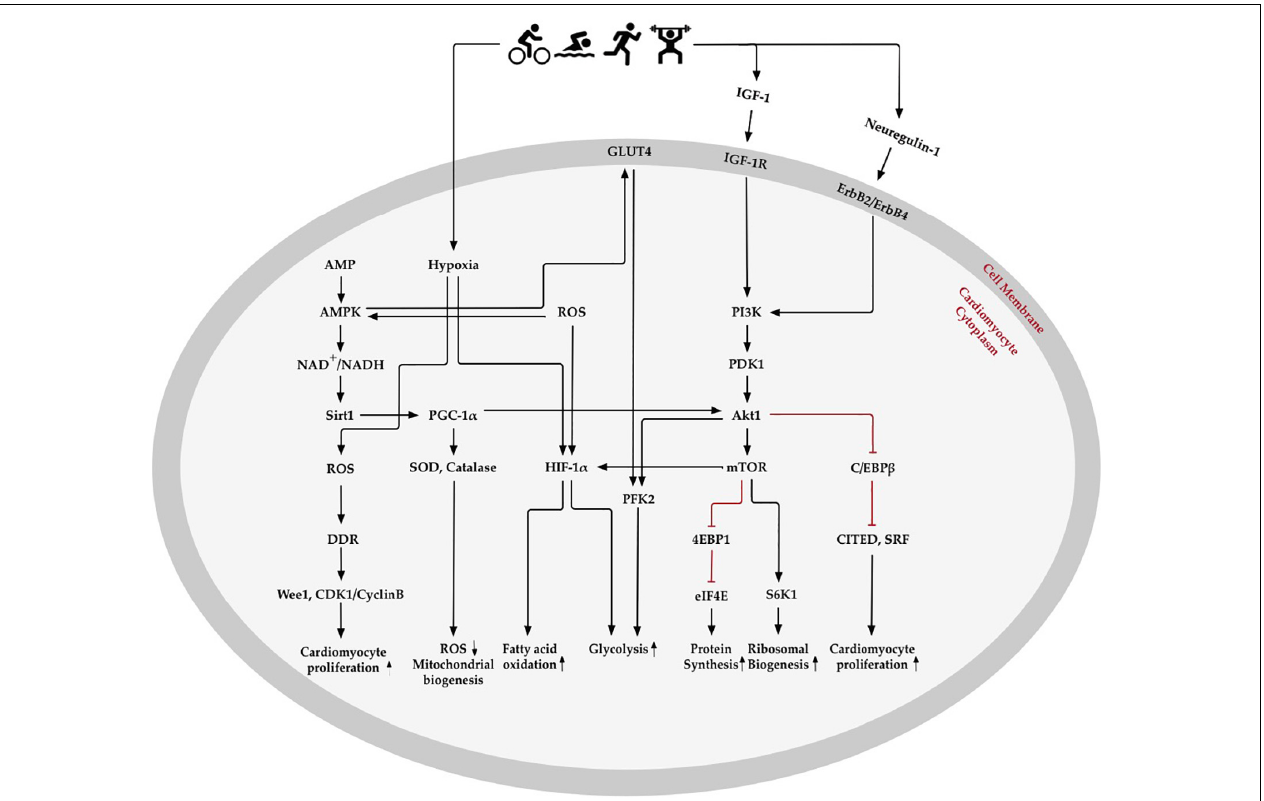
FIGURE 3 | Oxygen metabolism-related pathways in exercise-induced cardiomyocyte regeneration. Exercise stimulates physiological signaling pathways, such as those involved in creating mild hypoxia, changes in fatty acid and glycolysis metabolism, elimination of reactive oxygen species (ROS), enhancement of antioxidative capacity, and regulation of the oxygen metabolic molecular pathway in the heart. AMP- activated protein kinase (AMPK) enhances mitochondrial biogenesis and energy metabolism through Sirtuins1 (Sirt1) and peroxisome proliferator-activated receptor- γ coactivator 1 α (PGC-1 α ), which increase antioxidative enzymes to promote ROS elimination and mitochondrial biogenesis. Exercise-induced hypoxia and increase in ROS content promotes hypoxia-inducible factors 1 α (HIF-1 α ) expression, which decreases fatty acid oxidation and increases glycolysis. Insulin-like growth factor 1 (IGF-1) and neuregulin-1 activate phosphoinositide 3-kinase (PI3K) and downstream Akt signaling pathways. Akt activates 4EBP1 and S6K1, downstream of the mechanistic target of rapamycin (mTOR), which may promote protein and ribosomal synthesis. Akt, RAC- α serine/threonine-protein kinase; CDK1, cyclin dependent kinase 1; C/EBP β , CCAAT/enhancer binding protein- β ; CITED4, CBP/p300-interacting transactivator 4; DDR, DNA damage response; eIF4E, translation initiation factor eIF4E; GLUT4, glucose transporter 4; IGF-1R, IGF-1receptor; PDK1, phosphoinositide-dependent protein kinase-1; PFK2, 6 phosphofructokinase/fructose-2,6-bisphosphatase; S6K1, ribosomal protein S6 kinase- β 1; SOD, superoxide dismutase; SRF, serum response